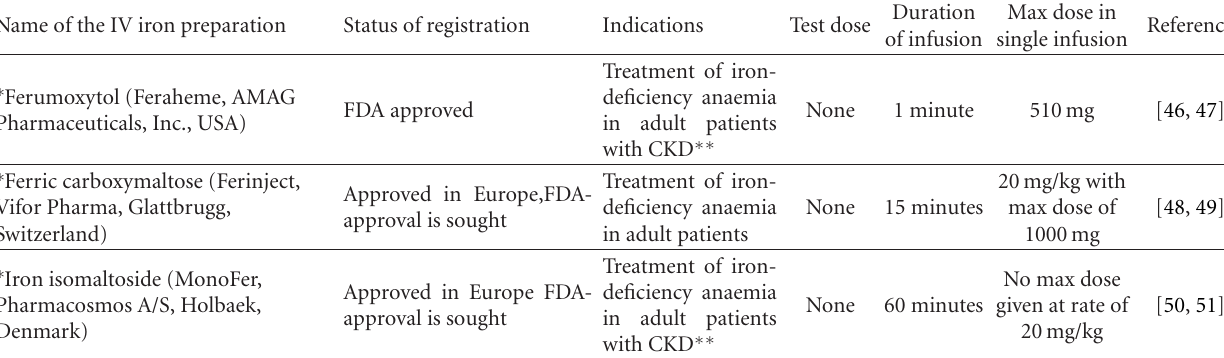
Table 1: Recently available intravenous (IV) iron preparations.